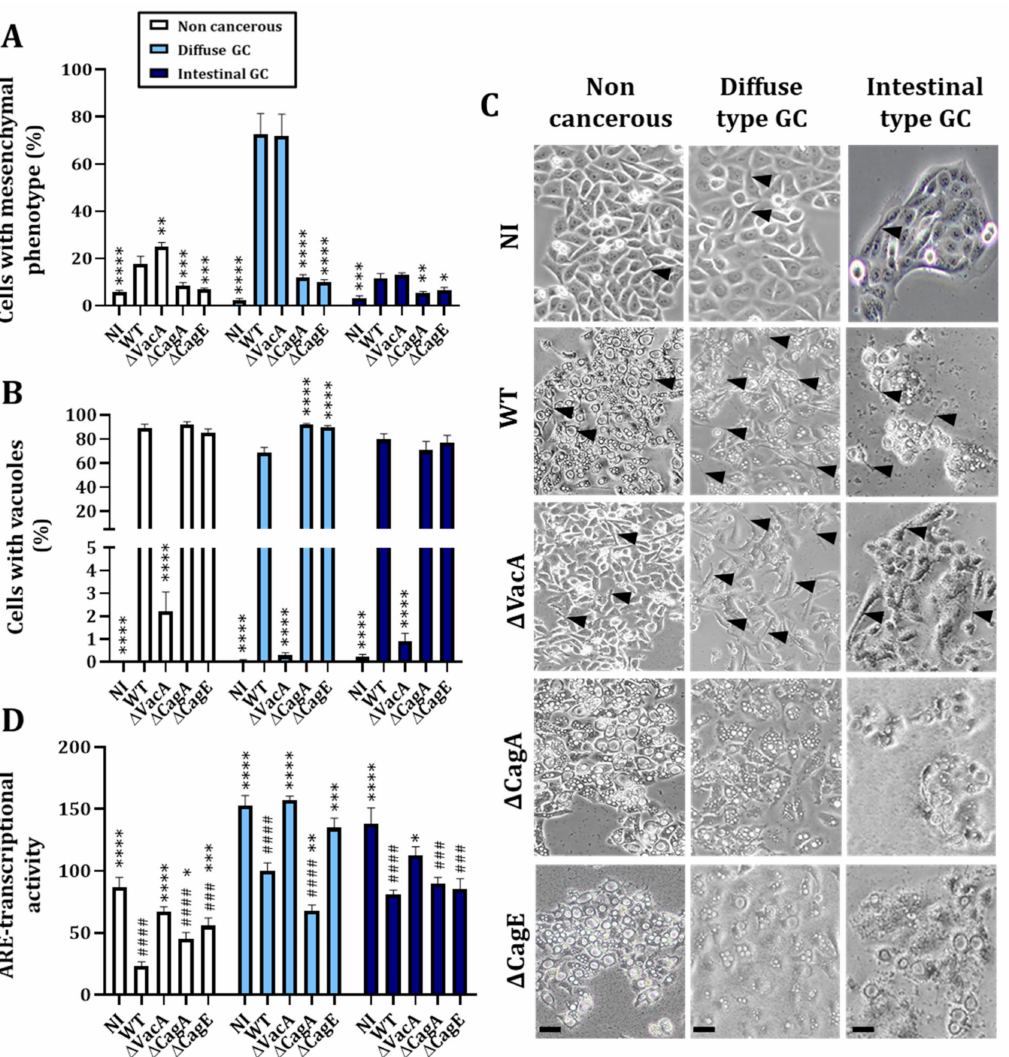
Figure 3. The virulence factor VacA is implicated in the decreased Nrf2 activity observed 24 h after infection with H. pylori . ( A ) Evaluation of the percentage of cells with a mesenchymal phenotype performed by phase contrast microscopy. ( B ) Evaluation of the percentage of cells with vacuoles performed by phase contrast microscopy. ( C ) Representative images of phase contrast microscopy of the three cell lines infected with the WT or with mutant H. pylori strains. Black arrows show cells with a mesenchymal phenotype. ( D ) Evaluation of the Nrf2 activity by assessing the Antioxidant Responsive Element (ARE) transcriptional activity by a biochemiluminescent assay. NI: uninfected cells. WT: H. pylori P12 wild type strain-infected cells. ∆ VacA: H. pylori P12 VacA deleted strain- infected cells. ∆ CagA: H. pylori P12 CagA deleted strain-infected cells. ∆ CagE: H. pylori P12 CagE, an essential protein for the T4SS assembly, deleted strain-infected cells. Mean ± SEM of 3–4 independent experiments. Statistics were performed per cell line with ANOVA followed by a Dunnet’s multiple comparisons test to compare all conditions to NI (#) or to WT (*). All p -value < 0.05 were considered significant. * < 0.05, ** < 0.01, ###/ *** < 0.001 and ####/ **** <